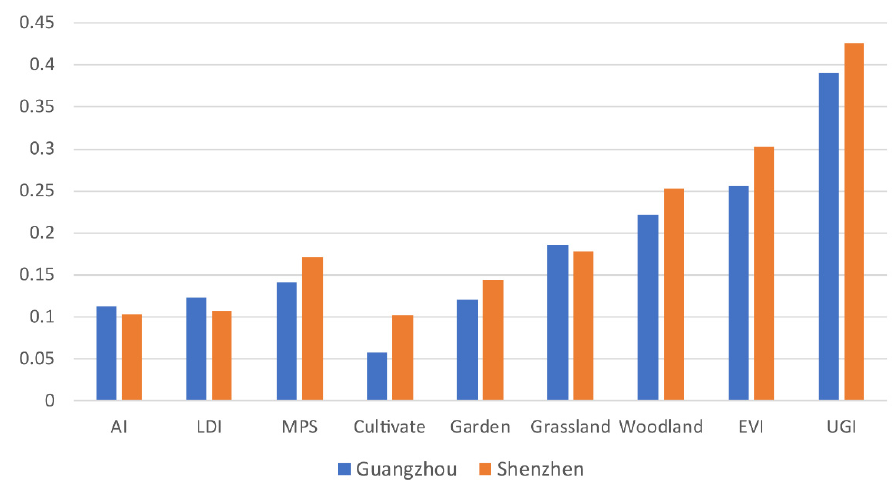
Figure 10. The PD values of UGI factors in different cities.